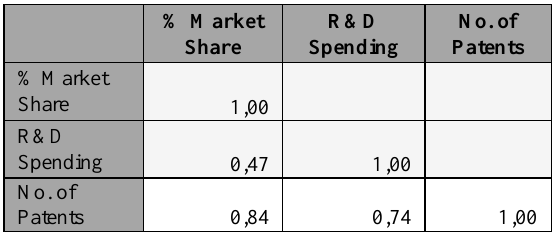
Table 11: Blackberry Correlations of